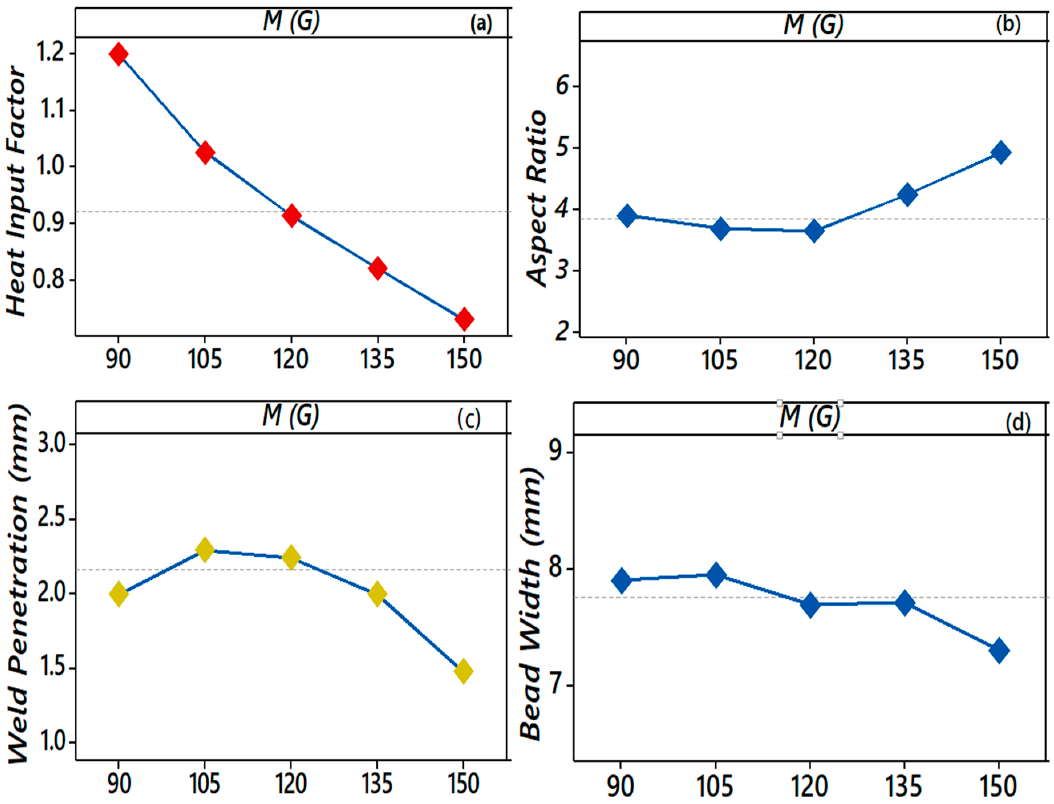
Figure 6. ( a – d ). Effect of the EMF on the HI f , AR , P , and W while keeping F , S , and G at 6 m/min, 600 mm/min, and 11 L/min